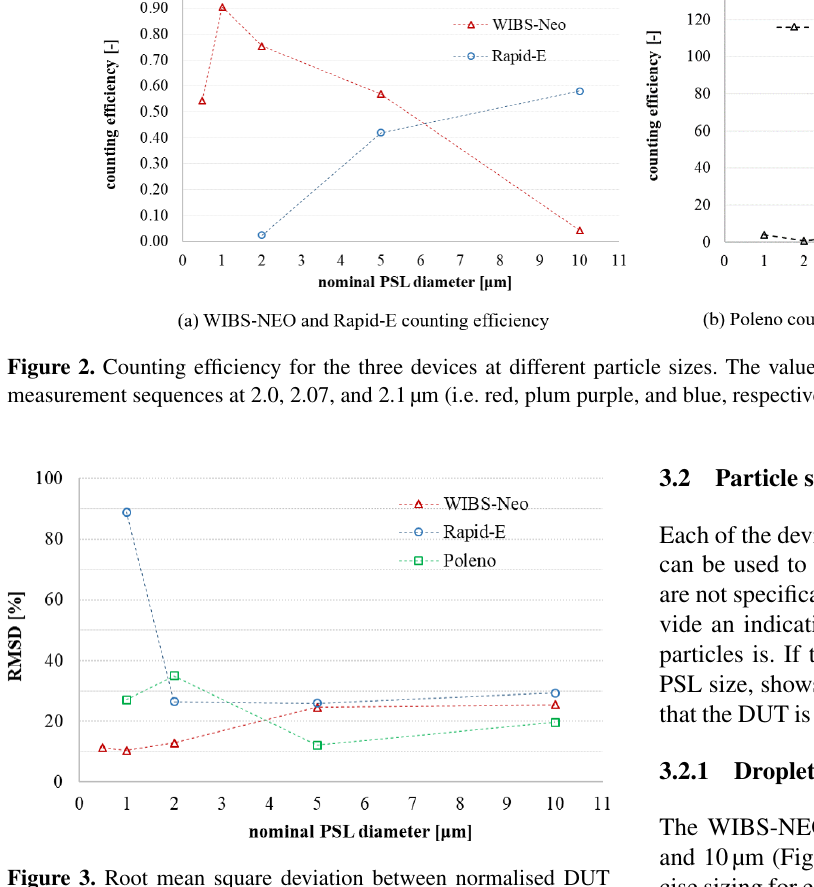
Figure 3. Root mean square deviation between normalised DUT and reference measurements. The value for 2µm is the mean value of the three measurement sequences with similar diameter (2.07, 2, and